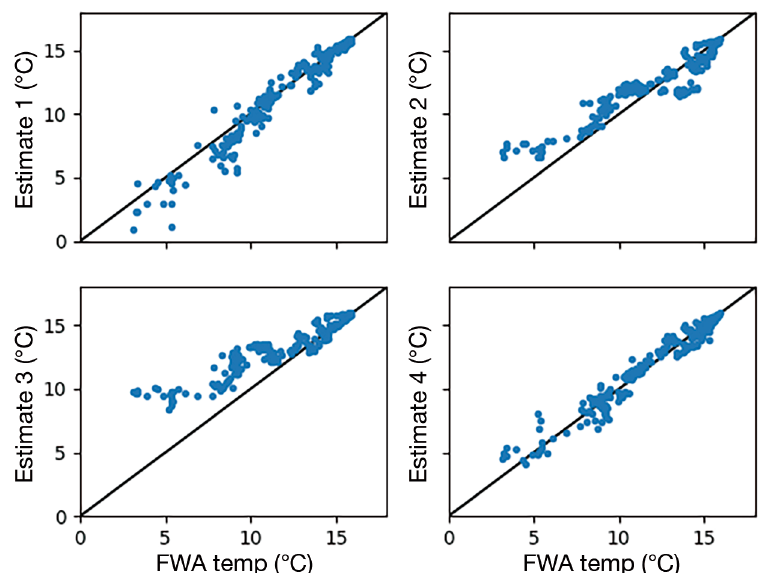
Fig. 5. Fish weighted average (FWA) temperature by the observed vertical distribution of salmon, plotted against 4 different estimated temperatures from the model. Daily values are plotted